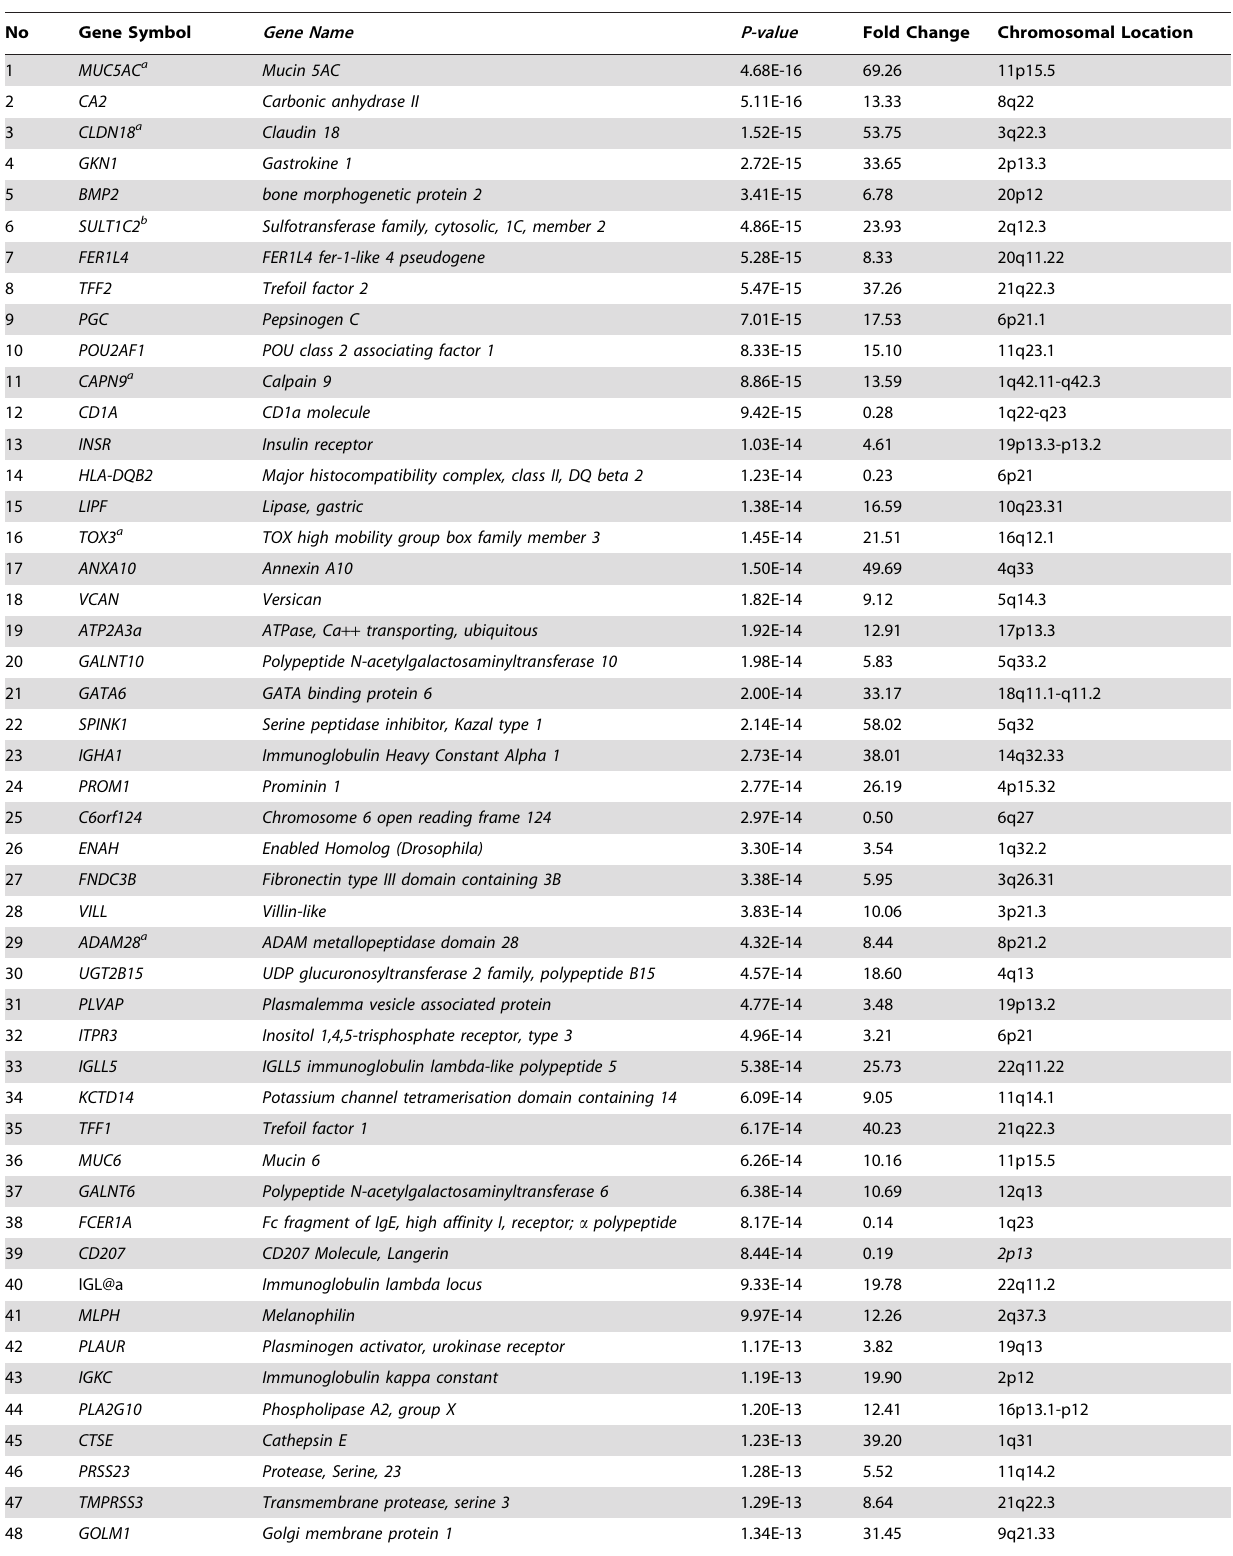
Table 2. Summary showing top 50 differentially expressed genes in BE vs NE (the complete list is reported in Table S4).